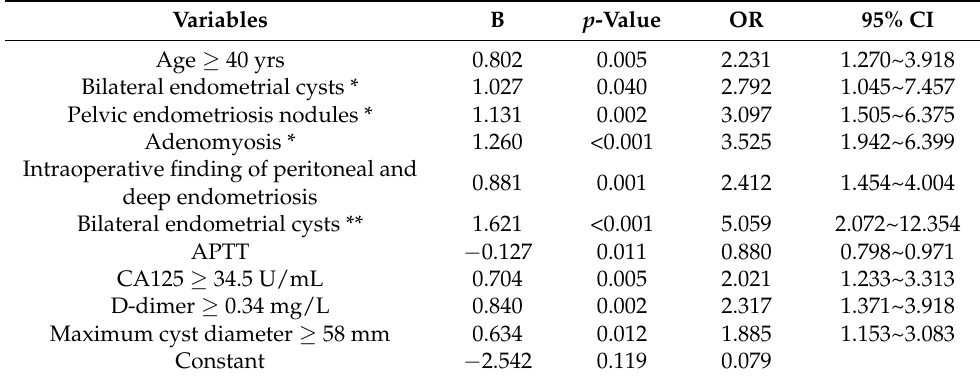
Table 5. Independent related factors of severe endometriosis.